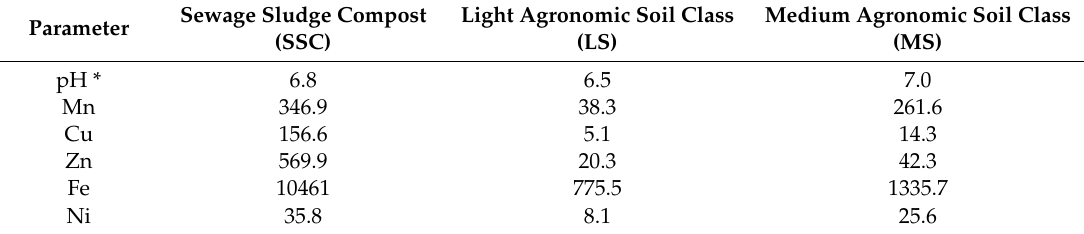
Table 1. Total contents (mg · kg − 1 ) of micronutrients in sewage sludge compost and soils used in the